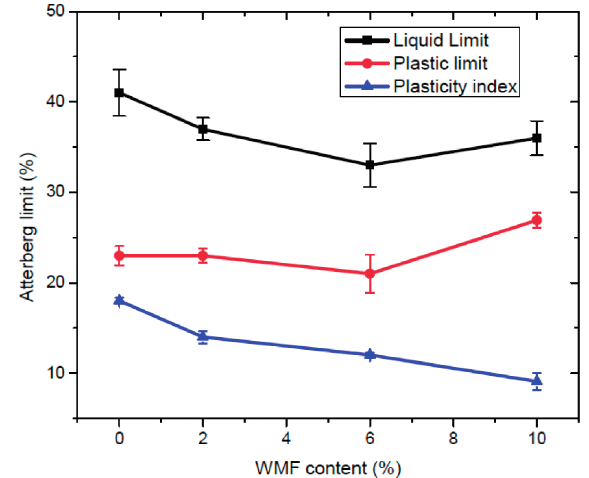
Fig. 5. Variation of Atterberg limits of the treated soil samples with their WMF